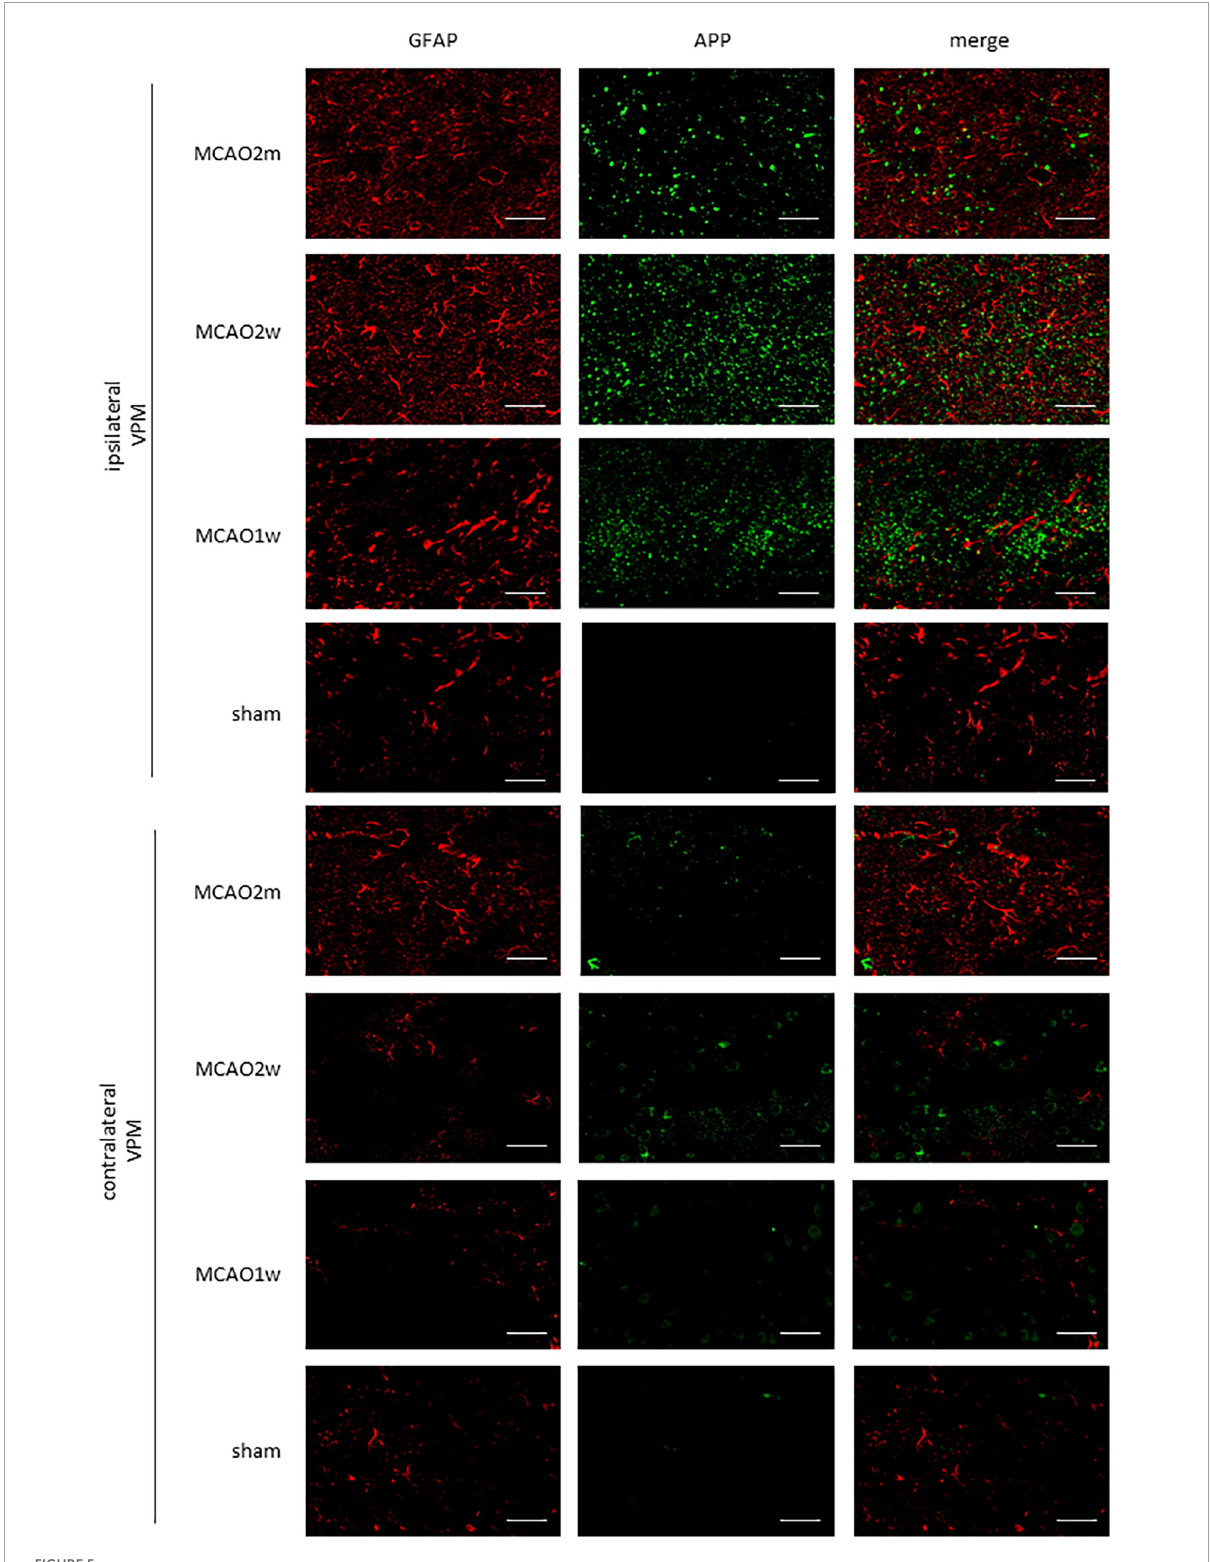
FIGURE5 APP in the ipsilateral and contralateral thalamus VPN. There was little APP deposition in the ipsilateral thalamus of sham rats and the contralateral thalamus VPN of all rats. Bar = 50 µ m. APP, beta-amyloid precursor protein; VPN, ventroposterior